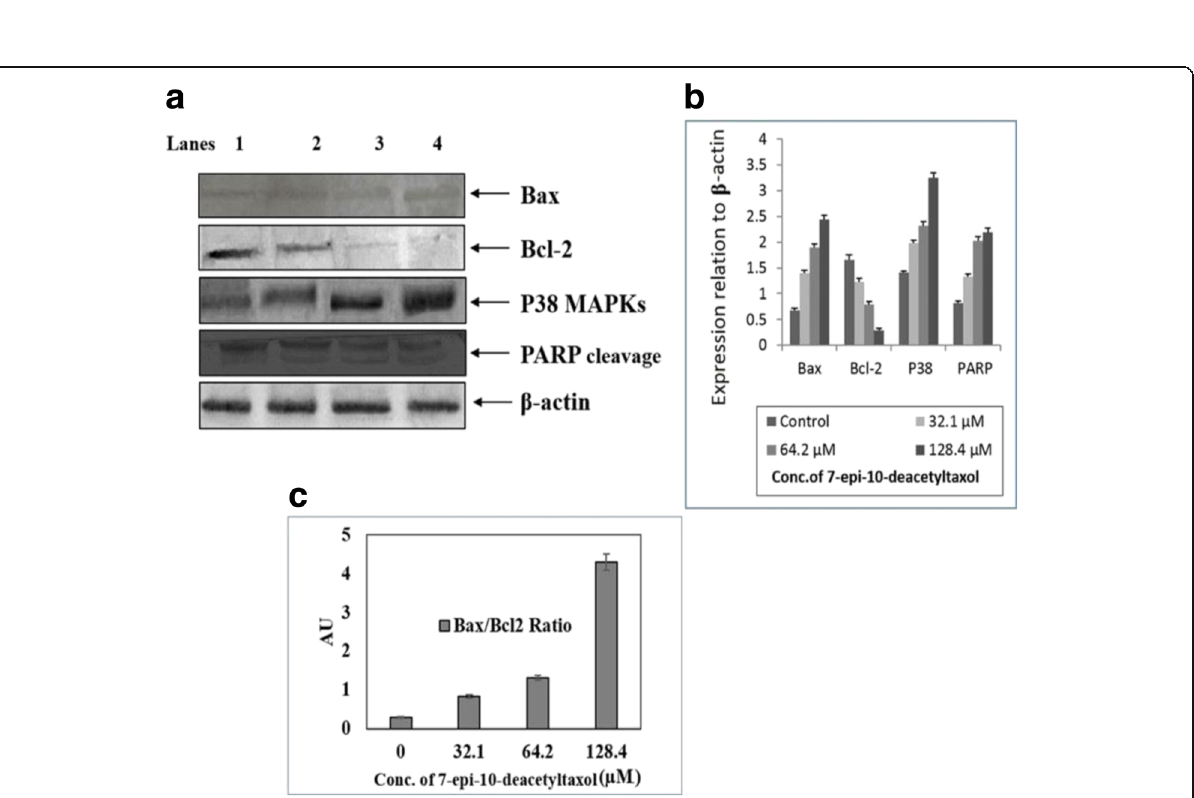
Fig. 12 Effect of fungal EDT on the expression of apoptosis-related proteins in HepG2cells. a Qualitative expression profile of selected proteins by western analysis. Lane 1 Untreated control cells, Lane 2 – 4 HepG2 cells with 32.1, 64.2 and 128.4 μ M, respectively of fungal EDT, ( b ) Quantitative analysis of expression of apoptosis-related proteins, ( c ) Histogram representing the ratio of pro-apoptotic Bax and anti-apoptotic Bcl-2 as a measurement of onset of